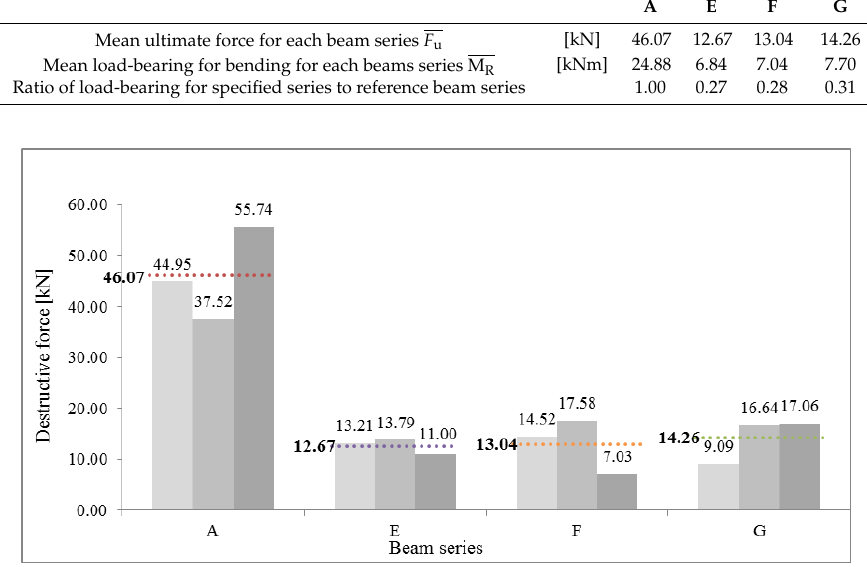
Figure 18. Comparison of values obtained for ultimate force values for beams of series A, E, F, and G.